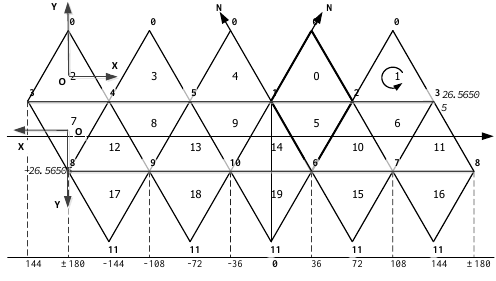
Figure 1. Indexes of vertices and faces in the icosahedron and the coordinate system in triangular face 3. ENCODING OF THE